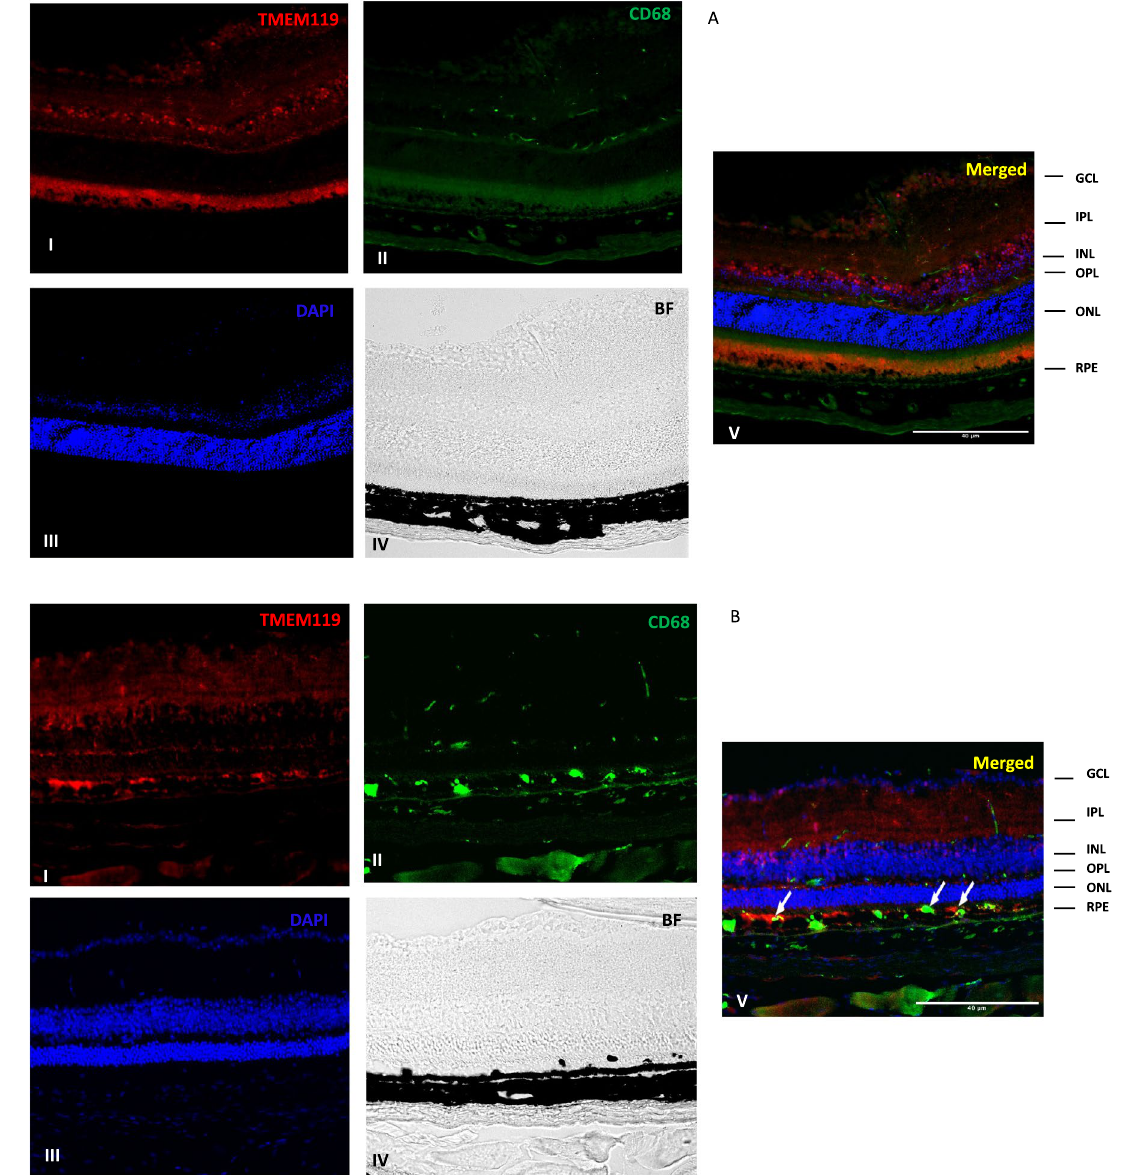
Figure 9. TMEM119 and CD68 immunostaining (A&B) (I-TMEM119-1, II-CD68, III-DAPI, IV-Brightfield (BF), V-Merged) was performed, microglial expressing TMEM119 were higher in WT mice retina compared with Mfrp KI/KI . In subretinal region TMEM119 and CD68 positive microglia were particularly present in Mfrp KI/ KI which completely absent from WT (white arrows) ( GCL ganglion cell layer, IPL inner plexiform layer, INL inner nuclear layer, OPL outer plexiform layer, ONL outer plexiform layer, RPE retinal pigment epithelial cell